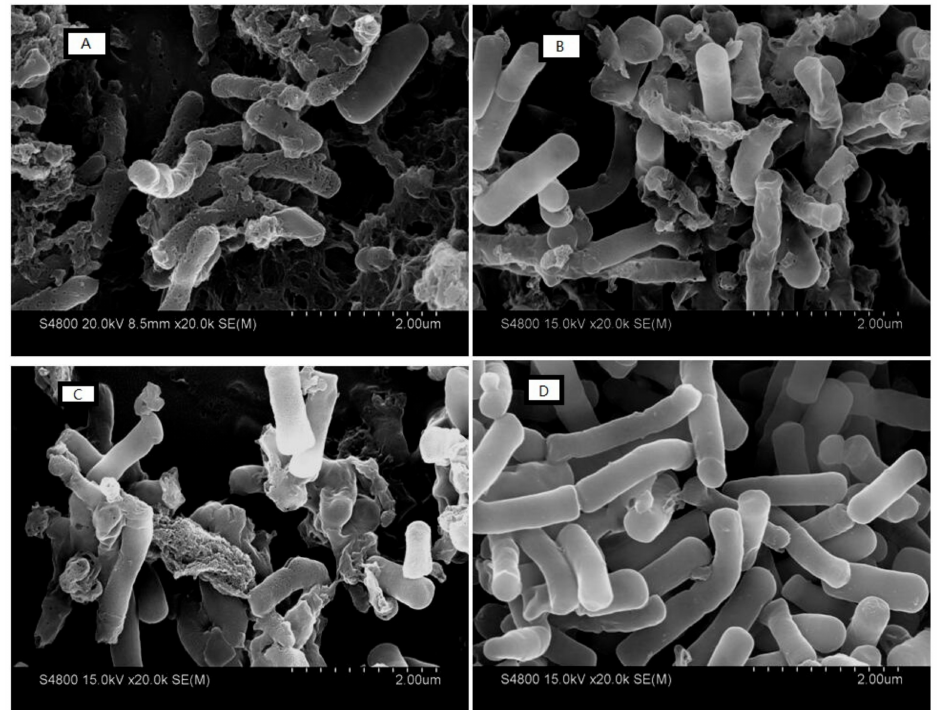
Figure 9. SEM micrographs of E. coli ATCC25922 cells treated with the antimicrobial